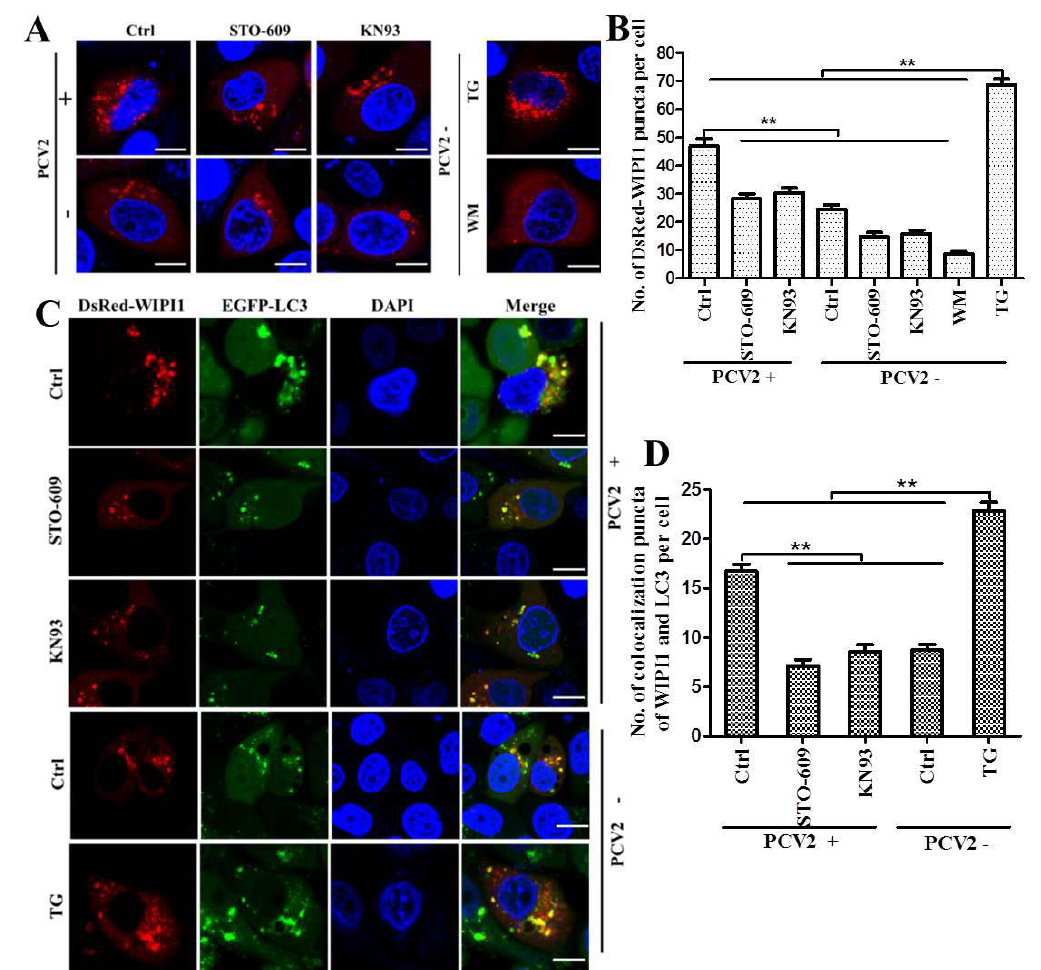
Figure 5. Formation of WIPI1 puncta and colocalization of WIPI1 and LC3 were increased by PCV2 infection, but decreased by treatment with STO-609 or KN93. ( A ) PCV2-infected cells were transfected with pcDNA3.1-DsRed-WIPI1 at 6 hpi, treated with STO-609 (10 μM) or KN93 (2 μM) at 6 hours post-transfection (hpt), and incubated for additional 24 h. 0.5 μM thapsigargin (TG) or 1 μM wortmannin (WM) was used as positive or negative control, respectively. Cells were examined for formation of DsRed-WIPI1 puncta under the confocal microscope (scale bar, 10 μM) at 36 hpi; ( B ) average number of DsRed-WIPI1 puncta per cell from at least 50 cells/experiment in three independent experiments; ( C ) pcDNA3.1-DsRed-WIPI1 was transiently transfected into PCV2 pre-infected PK-15 cells stably expressing EGFP-LC3 (PK15/EGFP-LC3) at 6 hpi (MOI ≈ 1) and treated with STO-609 or KN93 as above. Representative confocal images of colocalization of DsRed-WIPI1 and EGFP-LC3 in PK15/EGFP-LC3 cells are shown (scale bar, 10 μM); and ( D ) average number of colocalization of DsRed-WIPI1 and EGFP-LC3 puncta per cell from at least 50 cells/experiment in three independent experiments. Data are reported as the mean ± SEM (ns, p > 0.05; * p < 0.05; and ** p < 0.01).